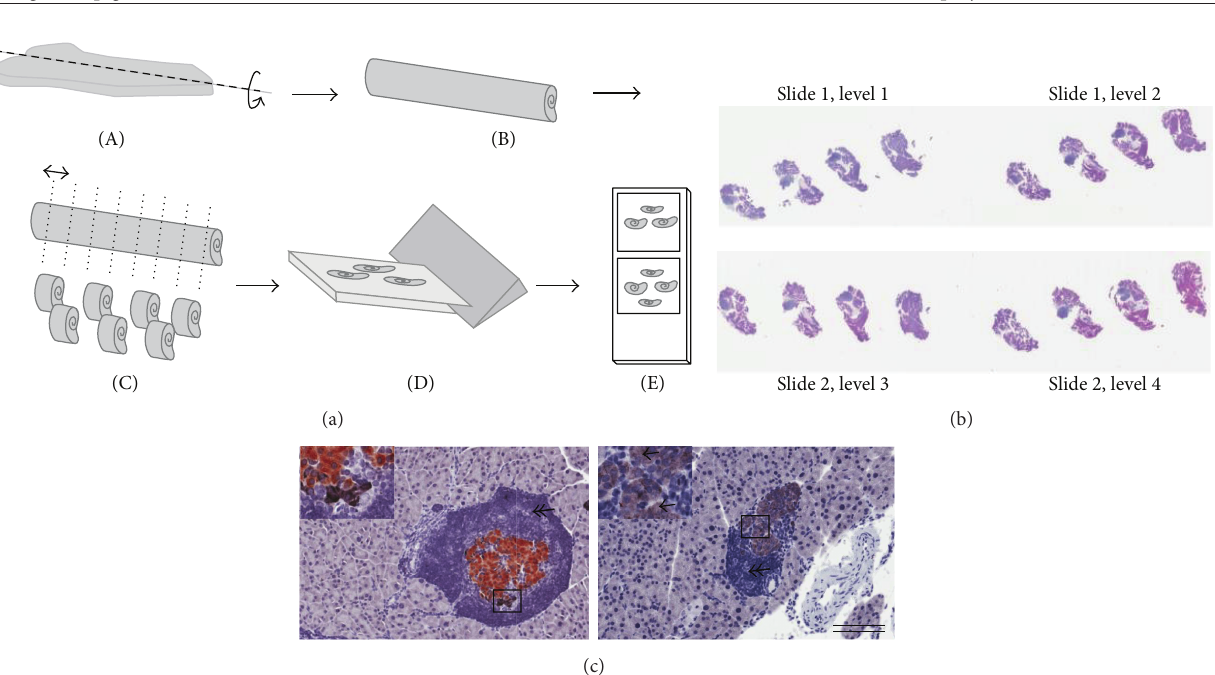
Figure 1: Schematic illustration of sampling principles for stereological assessment. (a) Formalin fixed pancreas samples were rolled tightly into strips of gauze, infiltrated in paraffin, and cut into 3-4 systematic uniform random tissue slabs with a razor blade fractionator and embedded in one paraffin block with the cut surface down. The blocks were trimmed and four sections for each animal were sampled 300 𝜇 m apart and arranged on two glass slides (b), representing a systematic uniform random sample of the whole pancreas. (c) Representative images of pancreatic sections from untreated mice demonstrating 𝛽 -cells (brown: insulin), non- 𝛽 -cells (black: glucagon, somatostatin, and pancreatic polypeptide), unstained endocrine cells (arrow), and surrounding immune cells (double arrow: hematoxylin). Scale bars = 400 𝜇